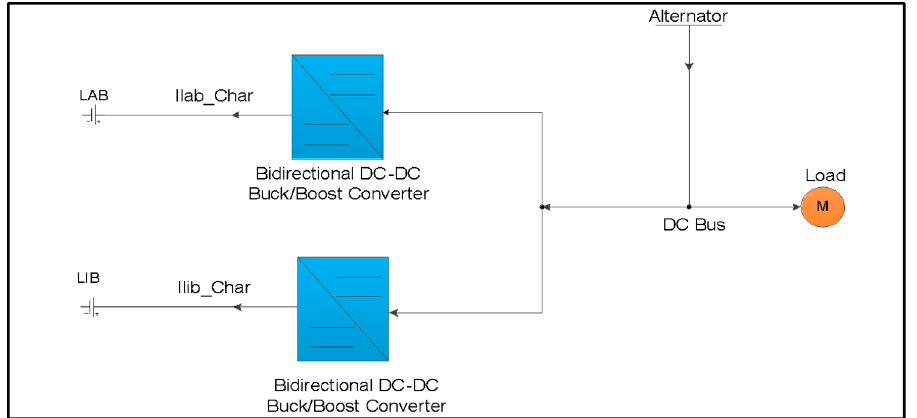
Figure 10. Topology of TV electrical power system when HESS charges.